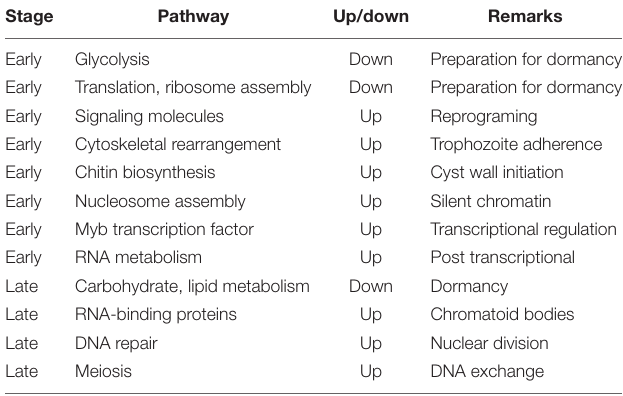
TABLE 1 | Important pathways in